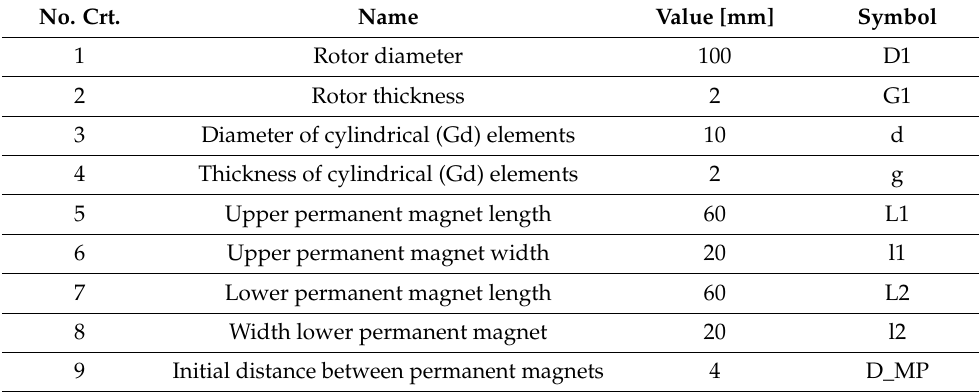
Table 1. Physical parameters of the model. No. Crt.